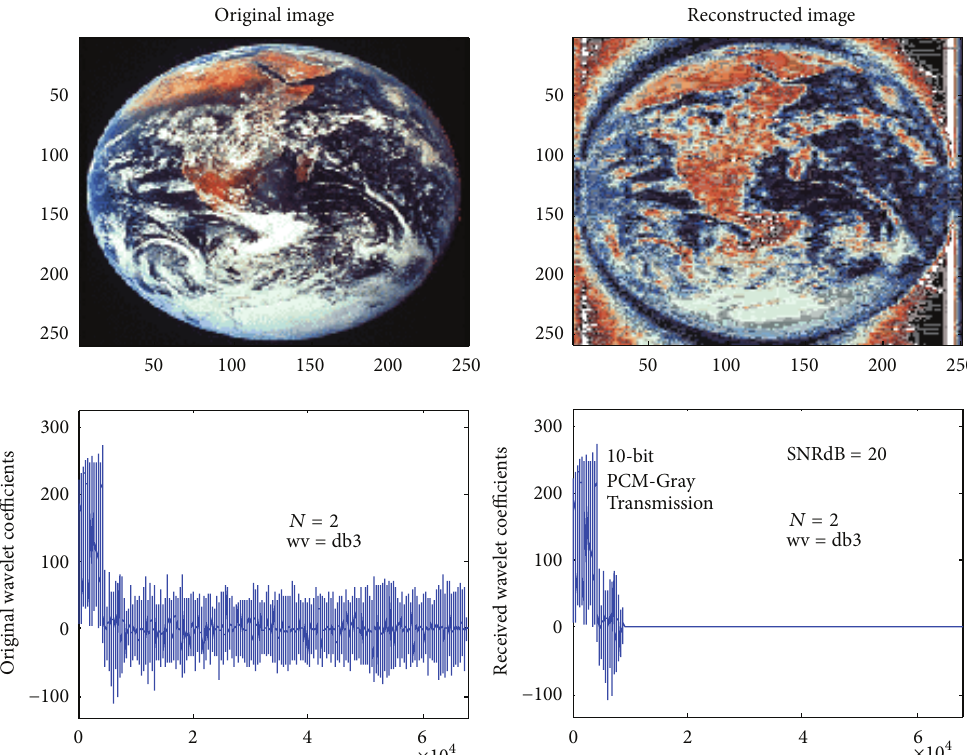
Figure3:Originalandreconstructedimageswiththeirwaveletcoefficientsusingsubbandcodingwaveletcompression.SNR=20 dB,retained energy = 90.6, MSE = 1.54, and MSSIM = 0.31.